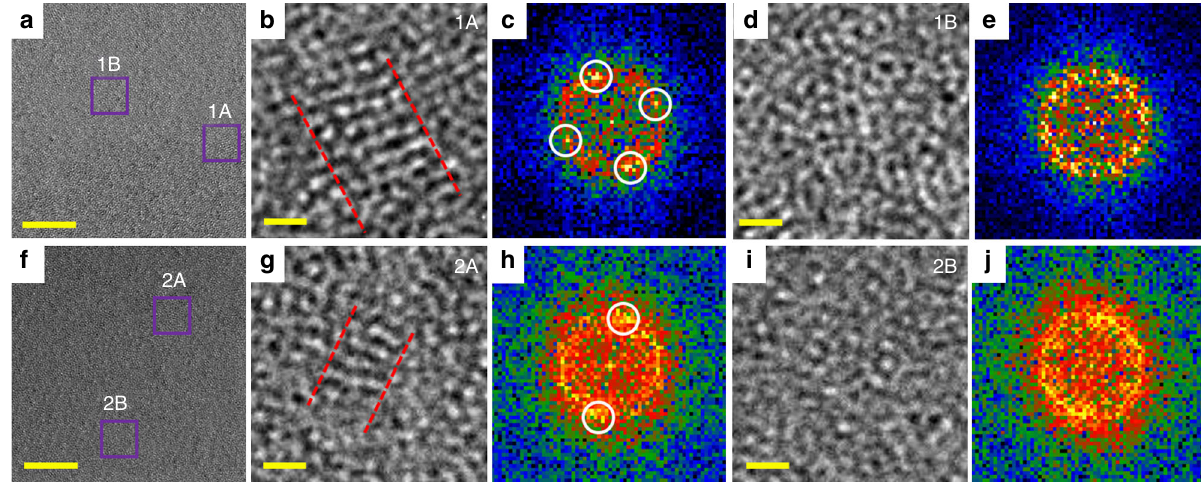
Fig. 4 HRTEM investigation of nanoscale heterogeneities. a , f 1A and 2A regions show nanocrystals in the amorphous matrix (1B and 2B). b, d, g, i HRTEM images and c, e, h, j corresponding FFT patterns taken from two different regions of the specimen with 8 nm thickness. . The spots encircled by white circles in the FFT patterns in ( c ) and ( h ) corroborate the presence of nanocrystals in the specimen, whereas no speckles are observed in the FFT patterns in ( e ) and ( j ) (scale bars, a and f — 5 nm, b , d , g , and i — 0.5